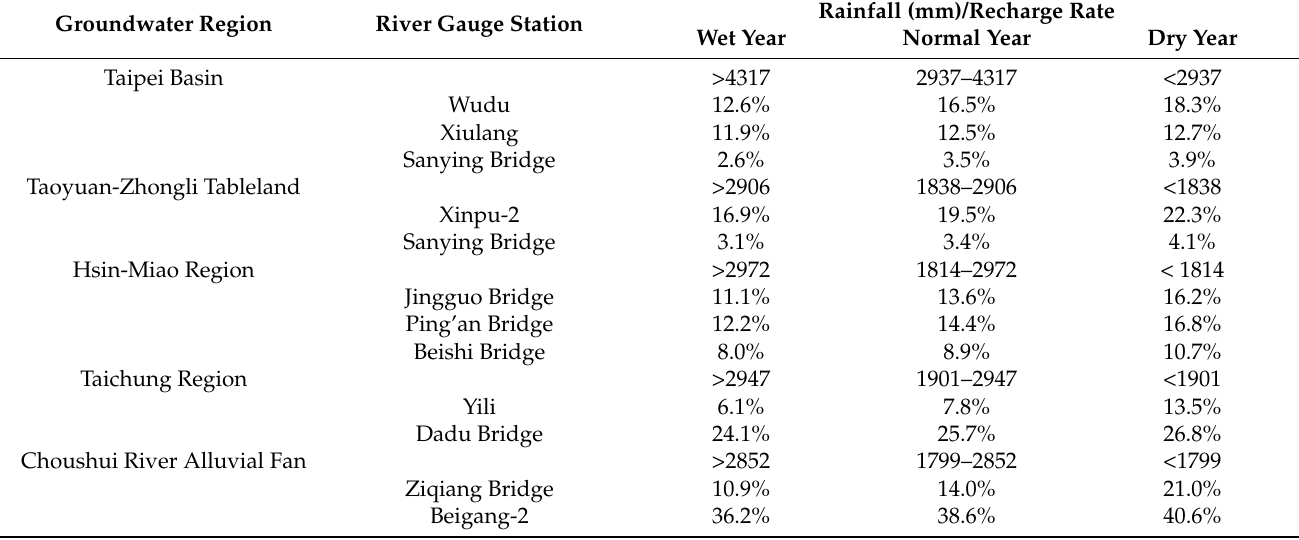
Table 4. Catchment rainfall and recharge rate under various